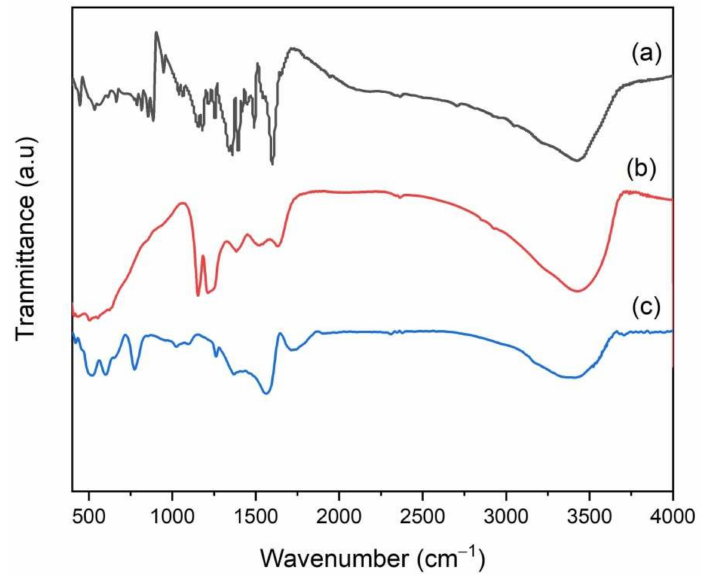
Figure 10. FT-IR spectrum of (a) MB, (b) MB adsorbed onto Ce 3+ /Ce 4+ -doped ZrO 2 /CuO before irradiation, (c) MB adsorbed on Ce 3+ /Ce 4+ -doped ZrO 2 /CuO 180 min after